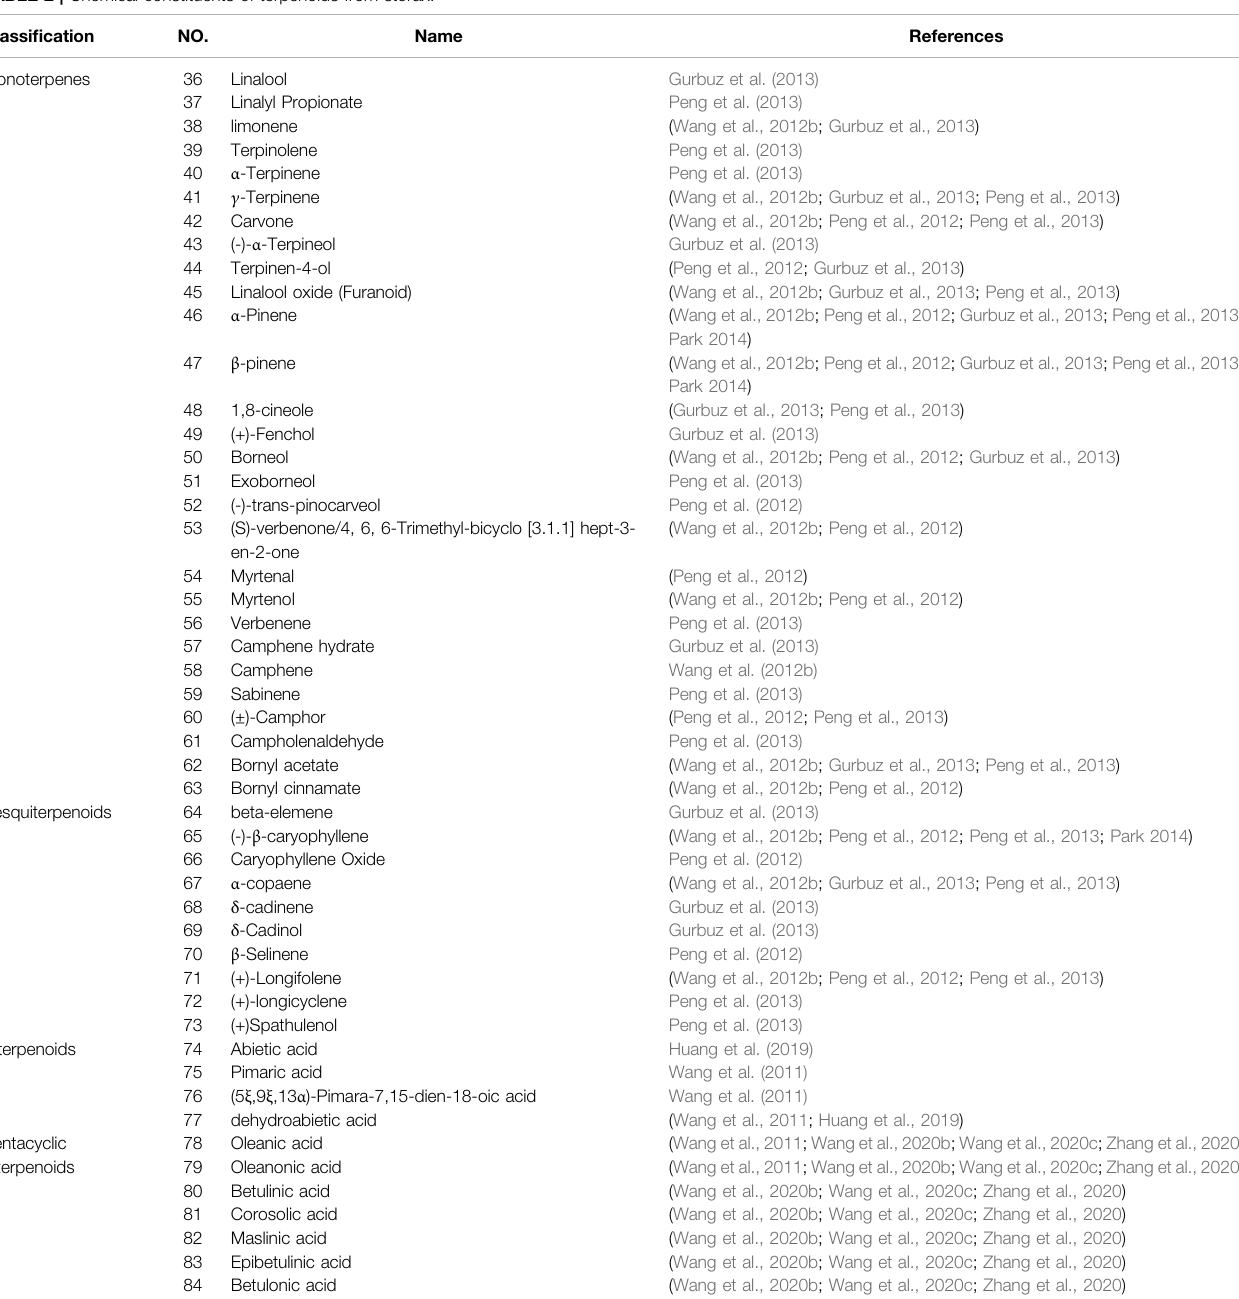
TABLE 2 | Chemical constituents of terpenoids from